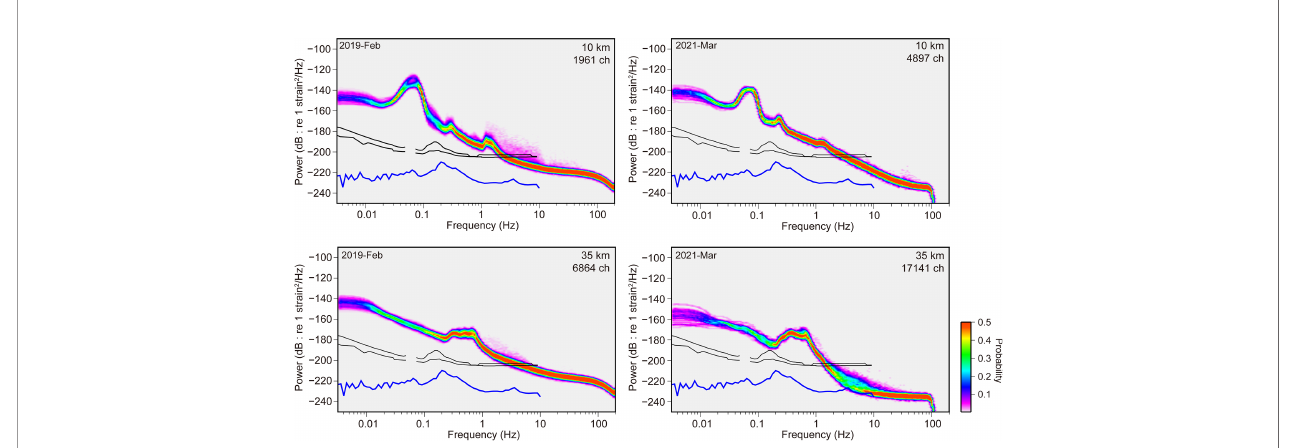
FIGURE 6 | The probability density functions of ambient noise spectra on the sea fl oor collected by the DAS observation carried out in February 2019 (left) and March 2021 (right). Spectra of the data at distances of 10 and 35 km from the landing station are shown. Phase data of the DAS measurement were converted to strain. Black lines show the spectra of strain-meter on land (Barbour and Agnew, 2011). The blue curve indicates a result of a laser strain-meter in deep vaults in Japan (Araya et al., 2017). The DAS measurement has low noise levels in frequency greater than 1